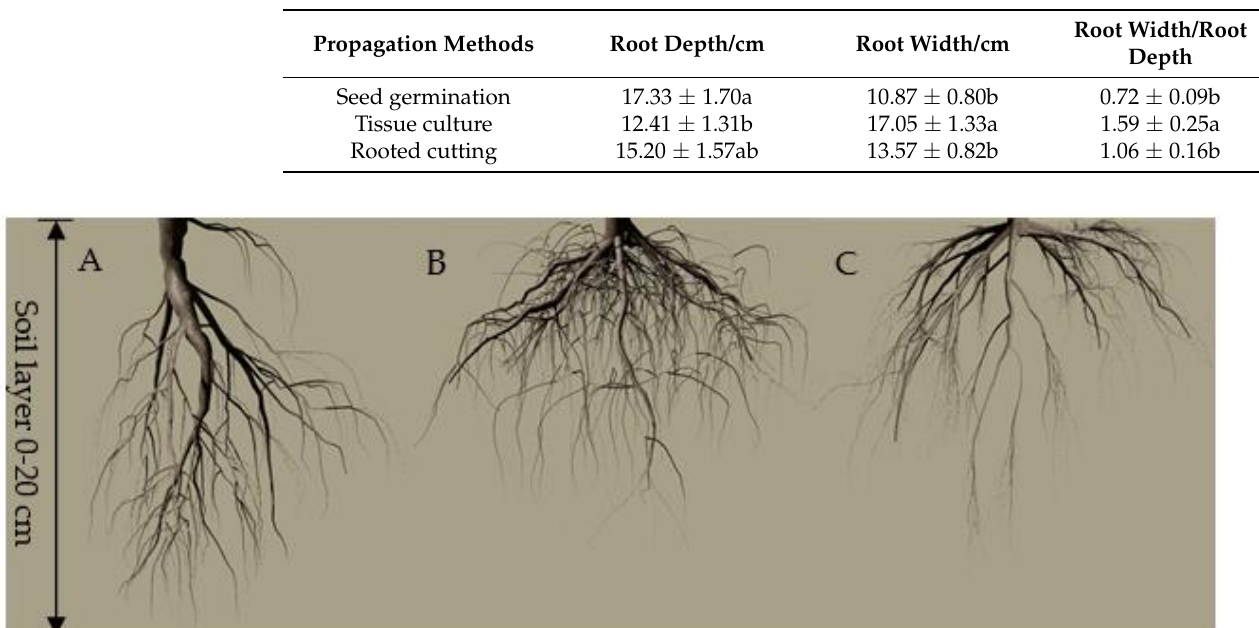
Table 2. Root spatial distribution traits. The same lowercase letters are not significantly different at the 5% probability level, while different lowercase letters indicate significant differences between the propagation methods.